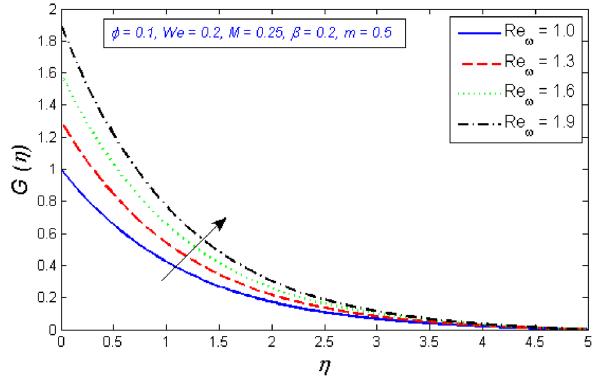
Figure 14. Variation of tangential velocity distribution for several number of Local Reynolds number established on the disc angular velocity Re ω .